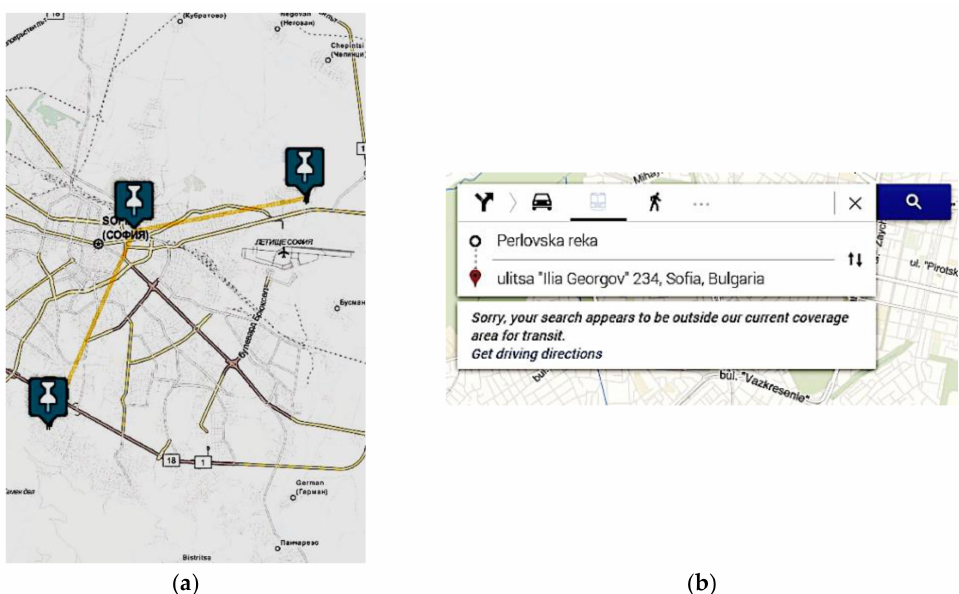
Figure 15. A comparative public transport route calculation (in Sofia): ( a ) EMRG result; ( b ) Google Maps